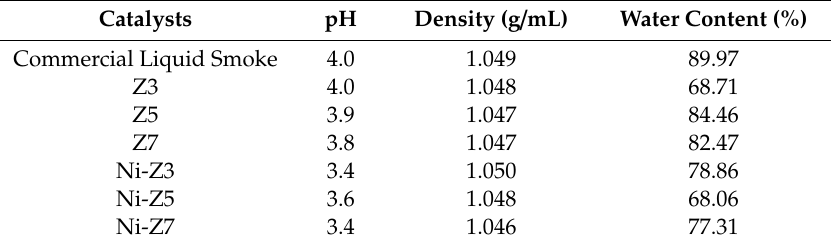
Table 8. Characteristics of commercial liquid smoke and HDO product.